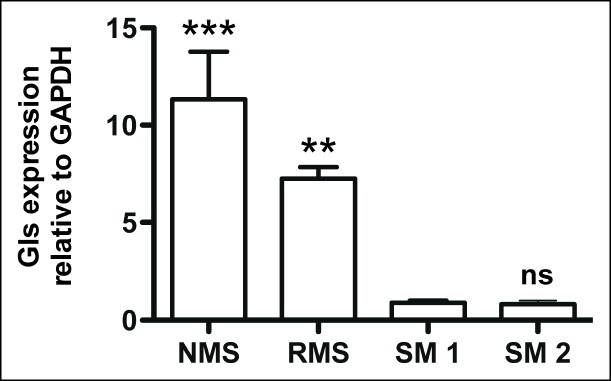
Glutaminase expression in mouse Kras;p16p19null sarcoma cells.Mouse Kras;p16p19null RMS and NMS cells express 7- to 11-fold higher Glutaminase levels compared to mouse skeletal muscle (SM; ns p≥0.05, * p<0.05, ** p<0.01, *** p <0.001; as determined by T-tests compared to normal muscle sample SM1).